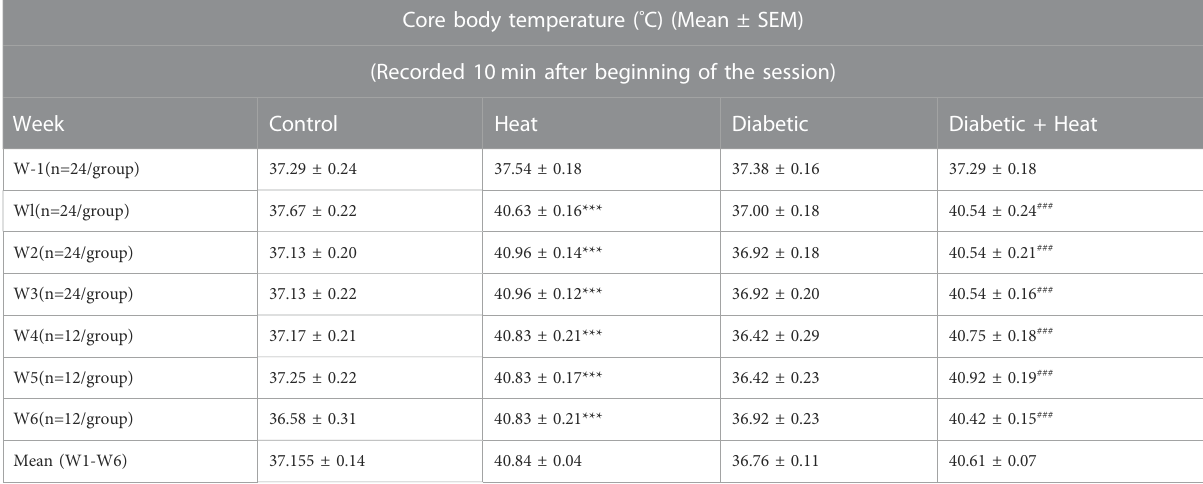
TABLE 1 Core body temperature ( ° C) (Mean ± SEM) measured 10 min after beginning of the session. Core body temperature ( ° C) (Mean ± SEM)